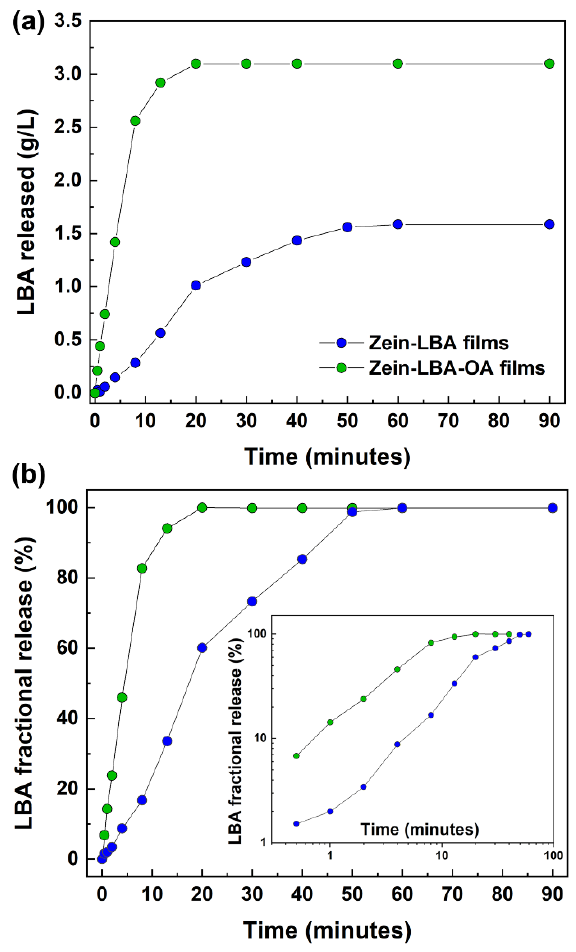
Figure 2. Evolution of LBA release in the physiological solution from zein-based films. ( a ) As recorded; ( b ) Normalized values with respect to the total release for the same systems, with corresponding data in the inset in the form of a log-log plot (Peppas Power law diffusion [31]).